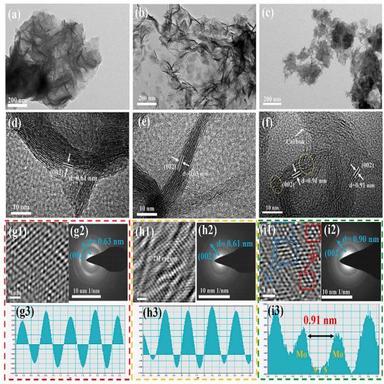
(a-c) TEM images, (d-f) HRTEM images of the MoS2, MoS2/G, and MoS2/C@G; (g-i) Insets 1, 3 show selected regional HRTEM images and the corresponding spectral line intensity analyses; inset 2 shows the SAED map.